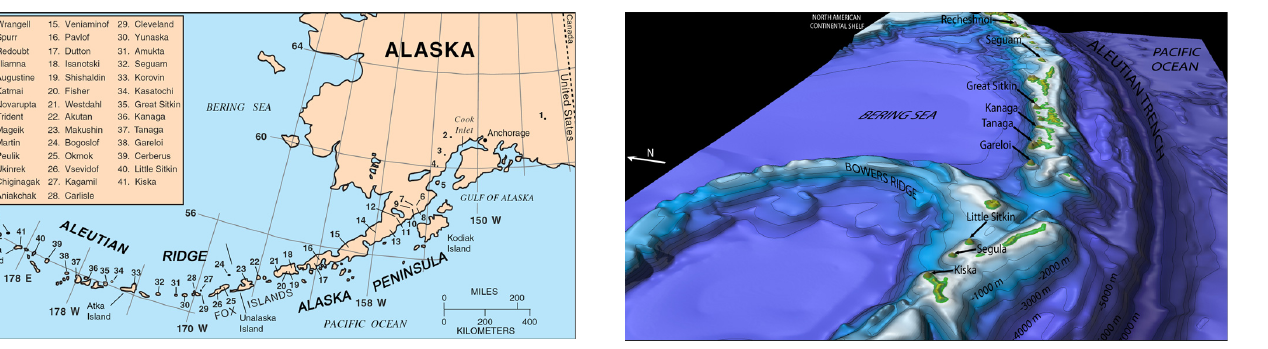
Fig. 2. 3-D view of the central Aleutian Ridge; it is clear how many of the stratocone volcanoes are located along the steepest north